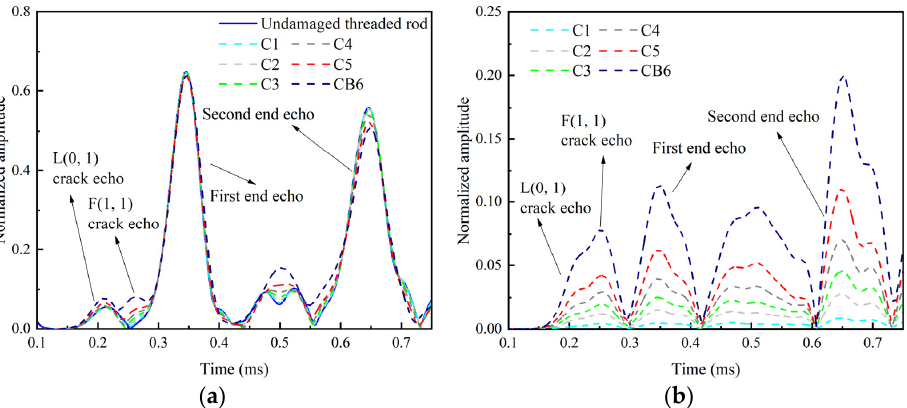
Figure 12. Time domain envelopes of signals at 60 kHz. ( a ) Time domain envelopes of full signals. ( b ) Time domain envelopes of residual signals.